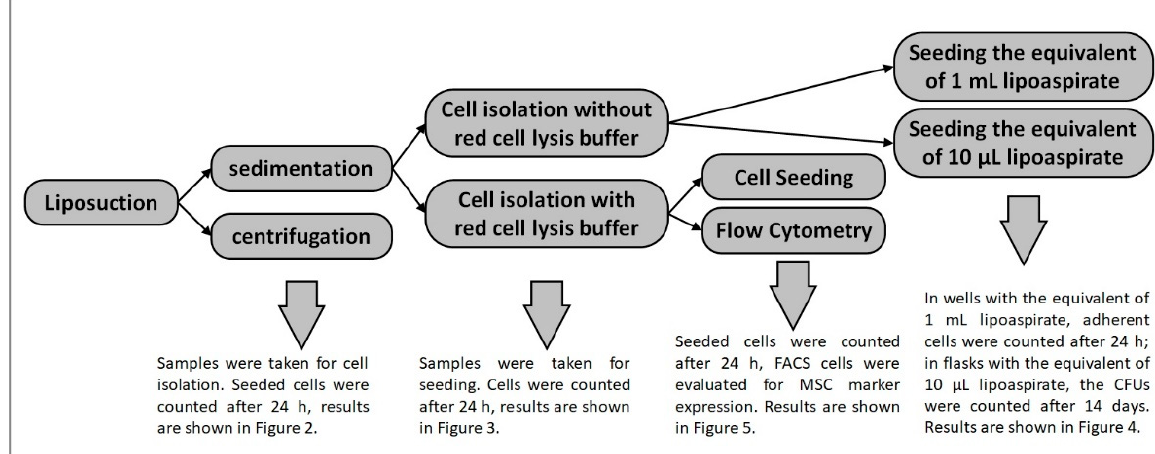
Figure 1. Schematic presentation of the experiment process. After liposuction the lipoaspirate is either allowed to sediment or centrifuged. An aliquot is taken from both samples and used for analysis of the parameter centrifugation. The rest of the sedimented lipoaspirate underwent the Adipose tissue-derived stem cell isolation protocol either with or without erythrocyte lysis buffer. An aliquot is taken from both samples and used for analysis of the parameter erythrocyte lysis. The rest of the cells isolated without lysis buffer are seeded in two different seeding concentrations and were analyzed for this parameter. The rest of the cells isolated with erythrocyte lysis buffer, which is a prerequisite for flow cytometry anyway, underwent either FACS analysis or were seeded as described above.